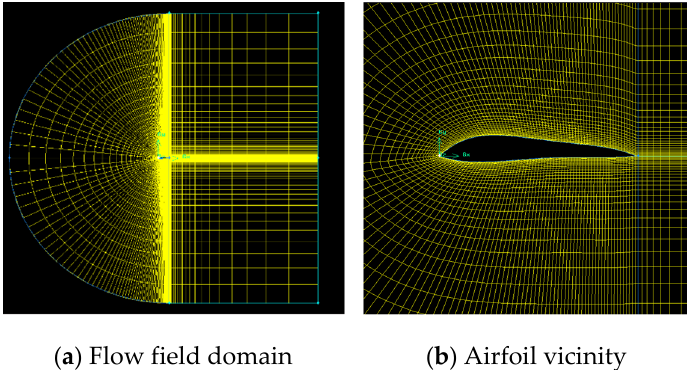
Figure 3. Generated mesh of CSA-KJ4412 airfoil.